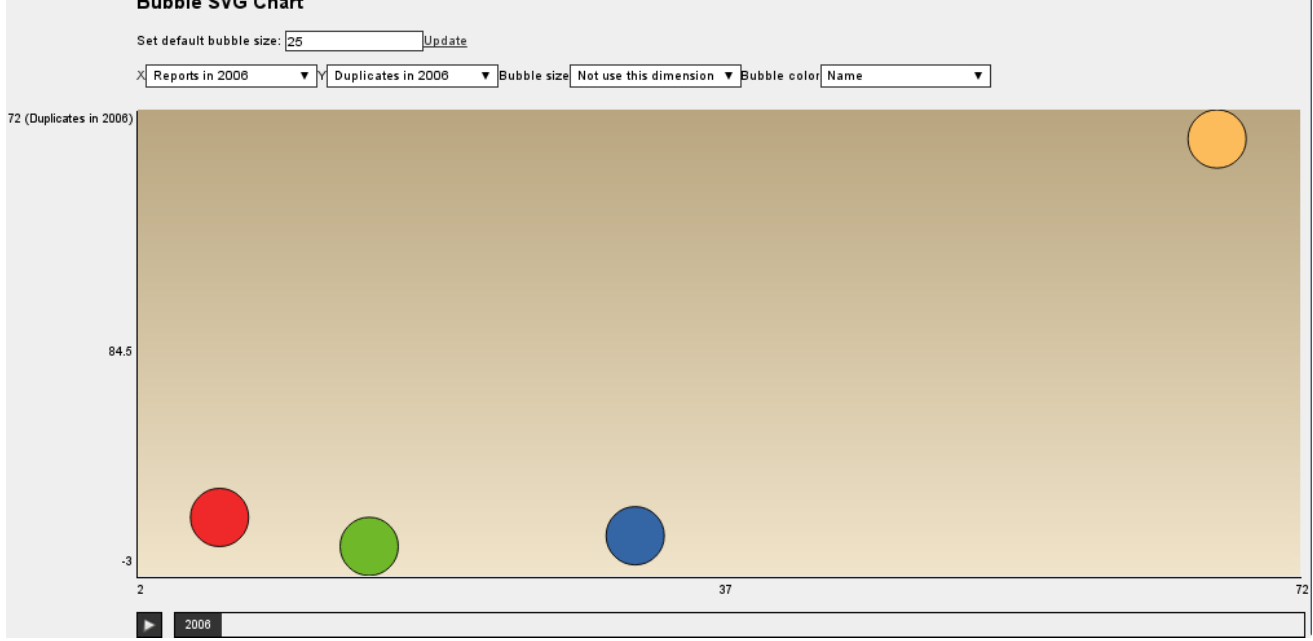
Fig. 15. Common datafile represented in a bubble chart: just one non-numeric variable (the hosting provider) and two numeric variables (total reports and distinct URLs) are represented in this